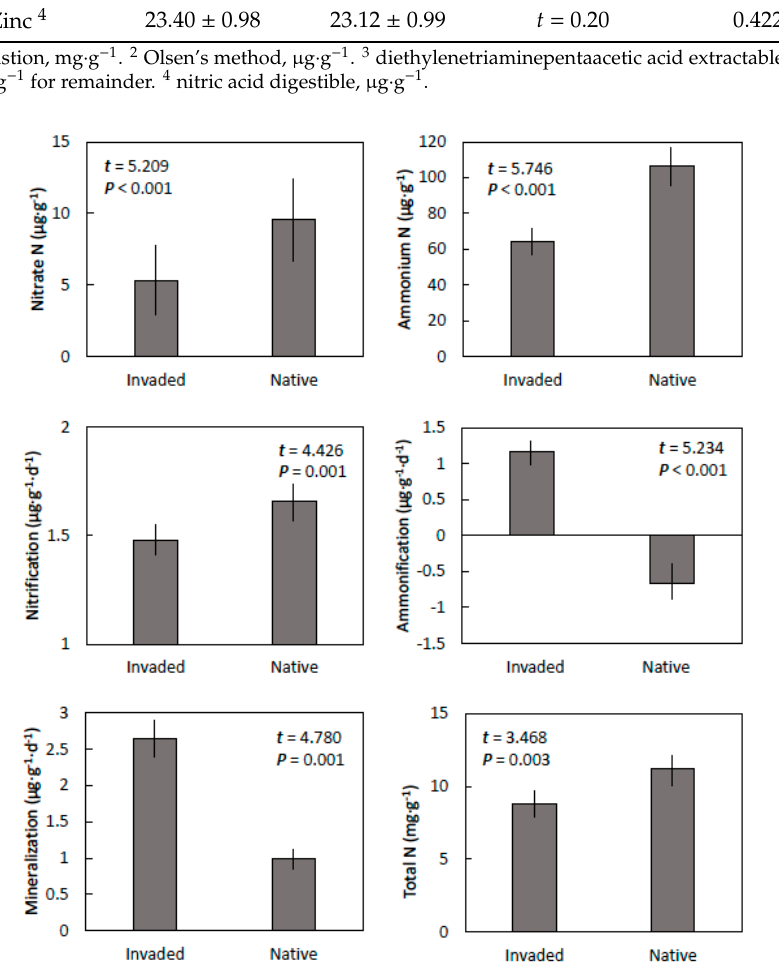
Figure 1. The nitrogen properties of Guam cobbly clay soils within invaded mature stands of. Vitex parviflora and in adjacent native forest in central Guam. Means ± SE, n = 6.